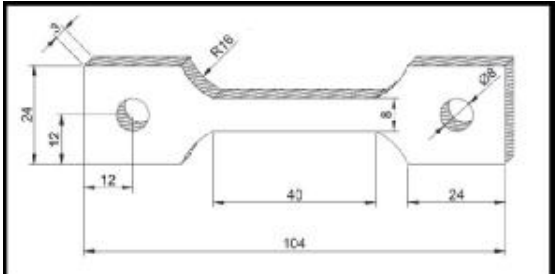
Fig. 2. Dimensions of Flat Specimen for the Uniaxial Tensile Test